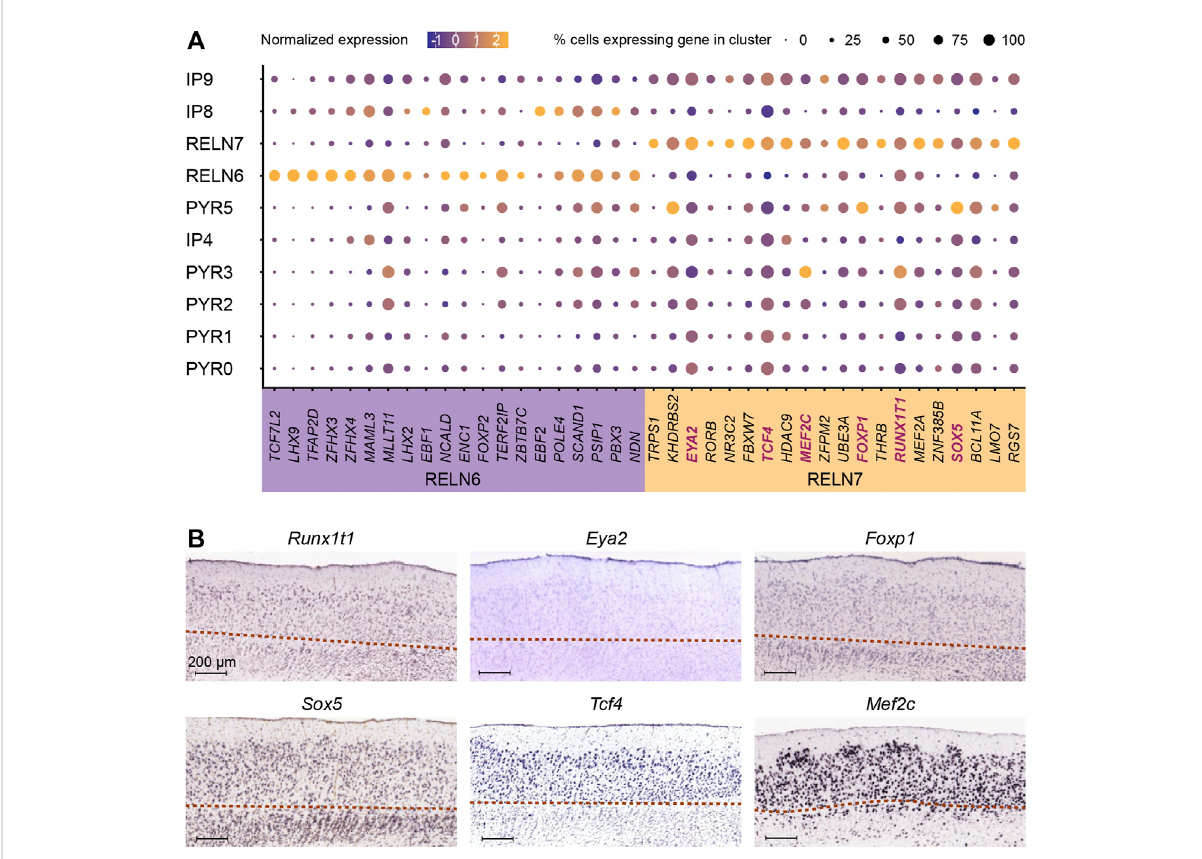
FIGURE 4 Uniquetranscriptional factors upregulated in RELN positive clusters. (A) Expressionofthetop twenty enriched transcriptionfactors(TFs,x-axis) were identi fi ed for each of the RELN -positive and putative stellate cell (SC) populations (RELN6, 7) and are visualized across the identi fi ed progenitor and excitatory neuron populations (y-axis) in the developing medial entorhinal cortex (MEC). The selected genes for reprogramming induced pluripotent stem cells (iPSCs) are highlighted in blue within the RELN7 cluster. (B) The laminar expression of the six stellate cell TFs ( Runx1t1 , Eya2 , Foxp1 , Sox5 , Tcf4 , and Mef2c ) was investigated by ISH in sagittal sections of the publicly available Allen Mouse Brain Atlas (Lein et al., 2004; 2007). Image credit: Allen Institute. The red dotted lines demarcate the lamina dissecans